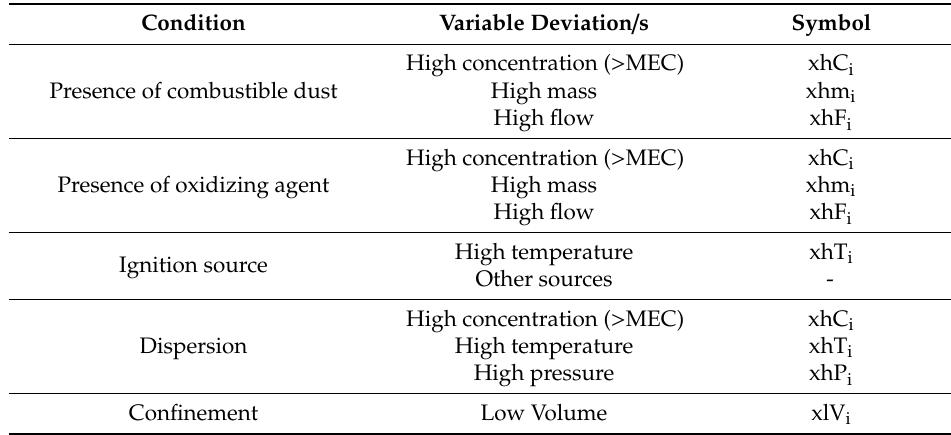
Table 2. Process variables related to the explosion pentagon. (x indicates a generic node, i indicates the equipment or substance which the variable is referred to; MEC—Minimum Explosive